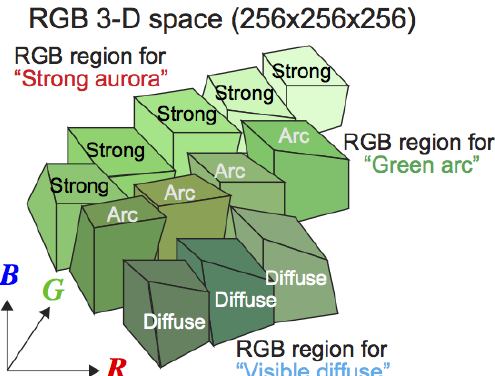
Figure 5. Schematic illustration of how the criteria of aurora pixels are constructed in the RGB color space. Each small box represents one of many criteria for one category (we call them “filter” in this paper) that we consider safe to judge as the aurora. By adding these “safe” criteria (with OR logic), we can cover a wide range of color (shifted from 558nm) as the aurora. The block shape is not neces- sarily rectangular because we use G, R / G, B / G, and H in different ways for different criteria. The exact conditions are given in Table 2. Such a restrictive definition allows the possibility of adding more pixels to be identified as the aurora pixels, such as pixels dominated by the N 2 red line (Fig. 4).